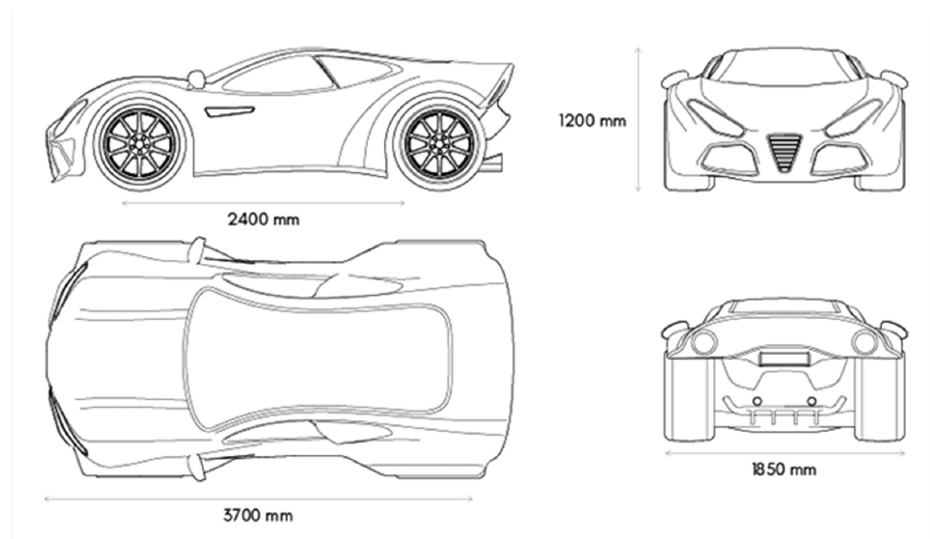
Figure 29. Natural concept 2D Drawings.